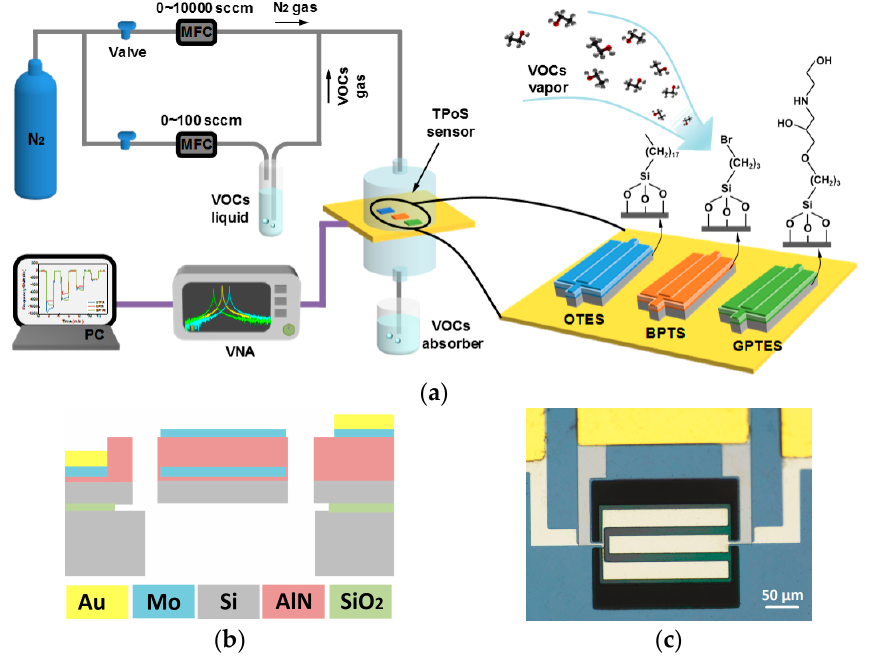
Figure 1. ( a ) Schematic of the gas sensing setup and a piezotransduced silicon bulk acoustic resonator (PSBAR) sensor array; ( b ) Schematic of the PSBAR structure; ( c ) An optical microscope graph of a PSBAR 120 μ m in width and 200 μ m in length.